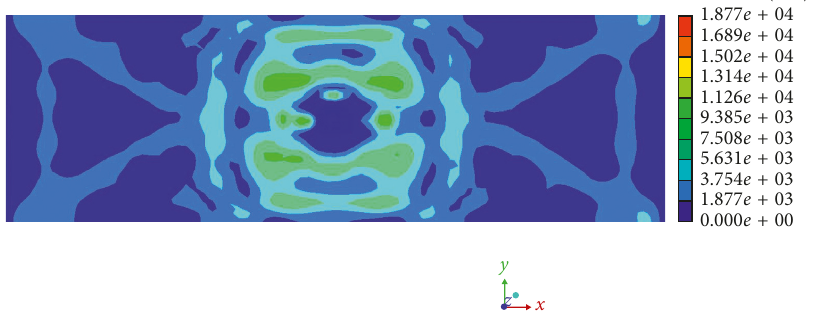
Figure 11: Stress distribution of concrete deck.